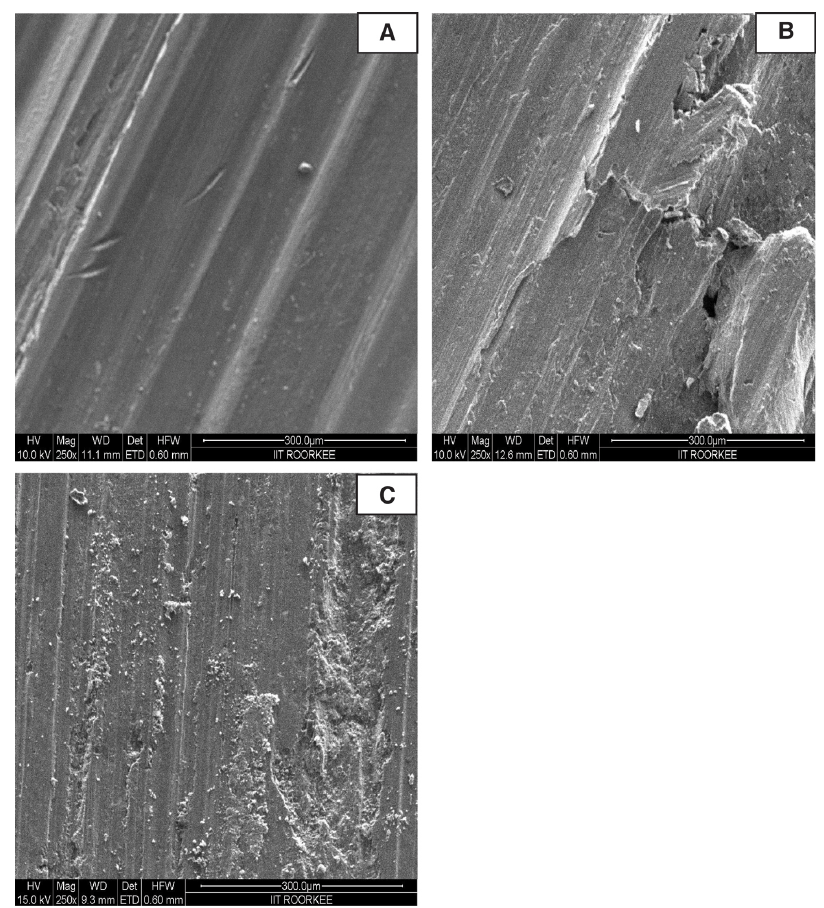
Figure 6: Wear behavior of NiTi alloy (A) at 200 rpm; (B) at 250 rpm; (C) at 300